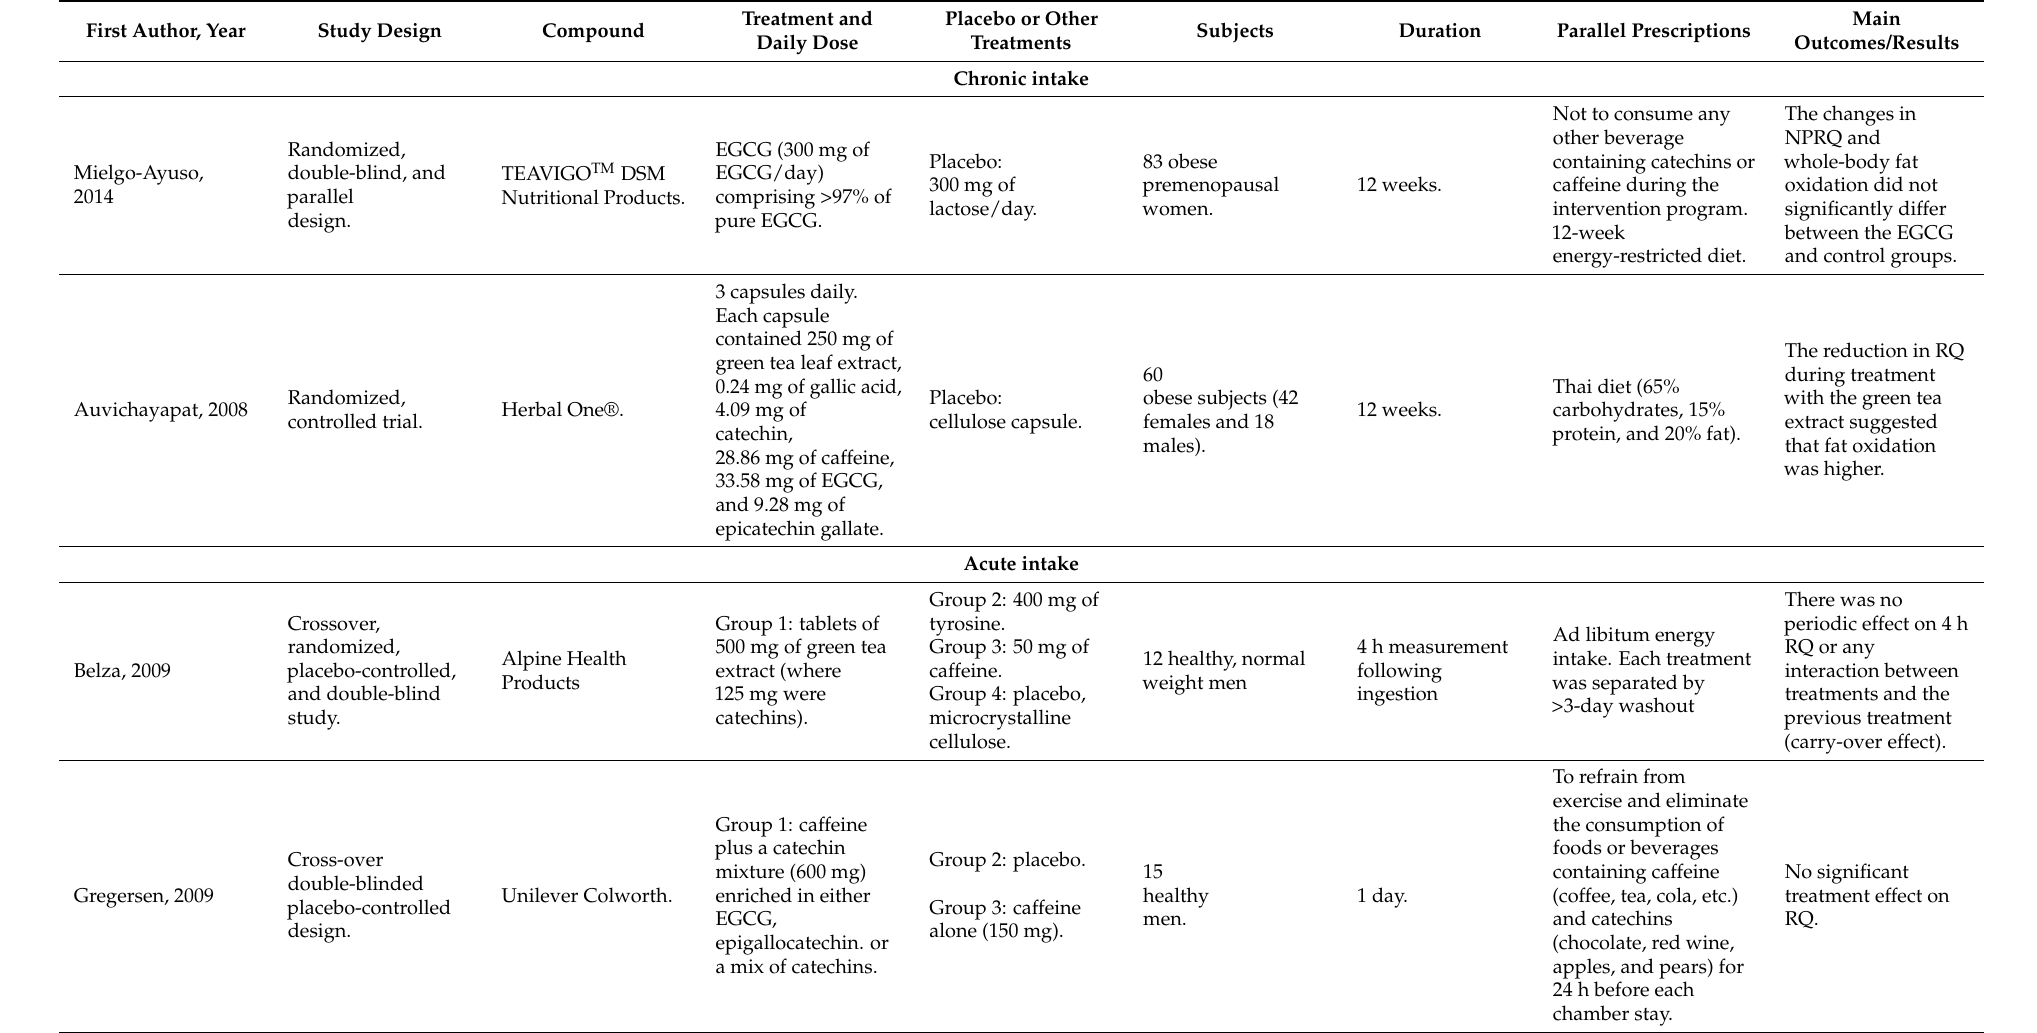
Table 3. Studies on the effects of GTC supplementation on respiratory